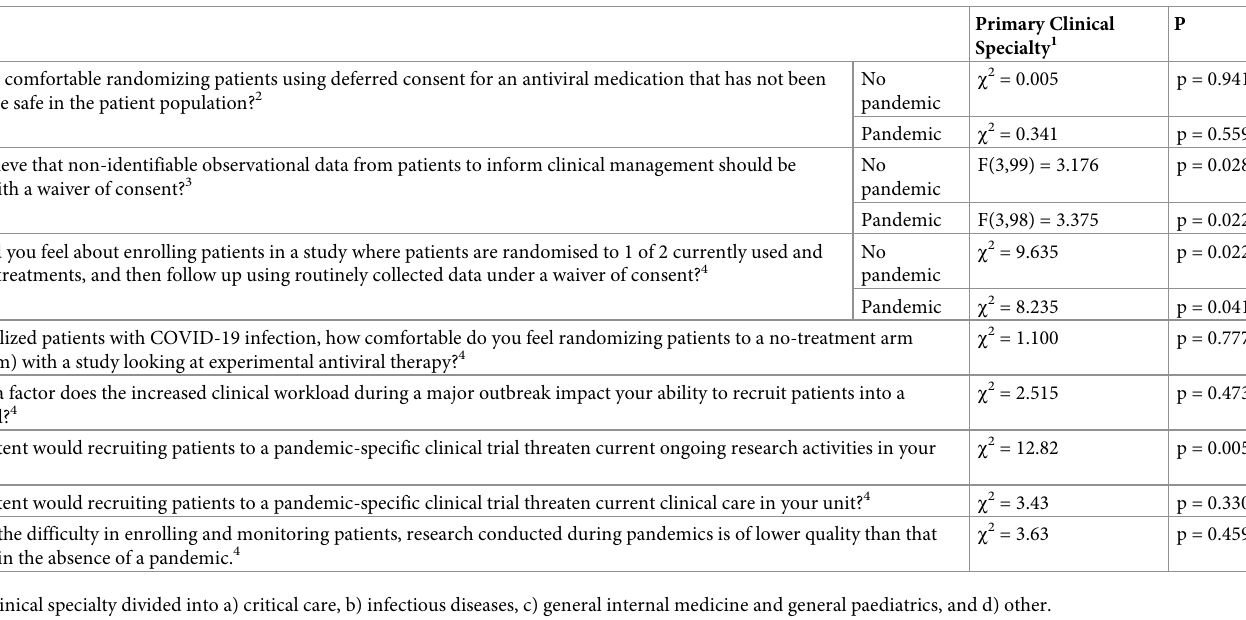
Table 3. Perspectives on research in pandemic settings by